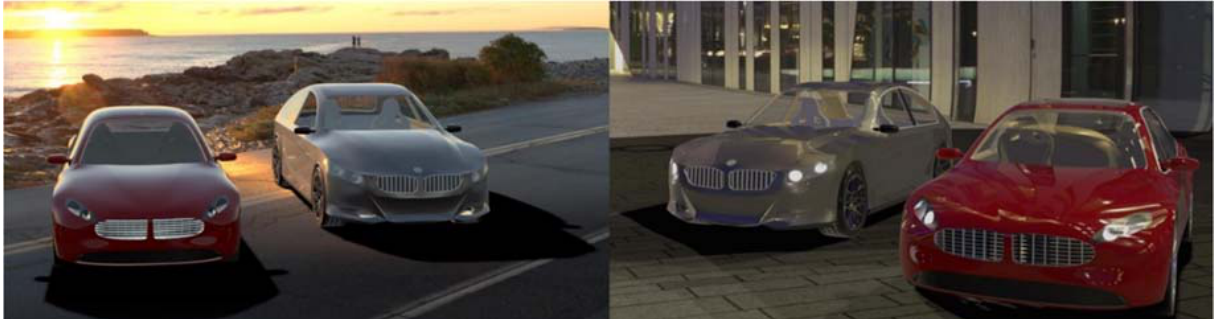
Figure 20. First rendering of Blitz Vision AS and Blitz Vision Retrò.